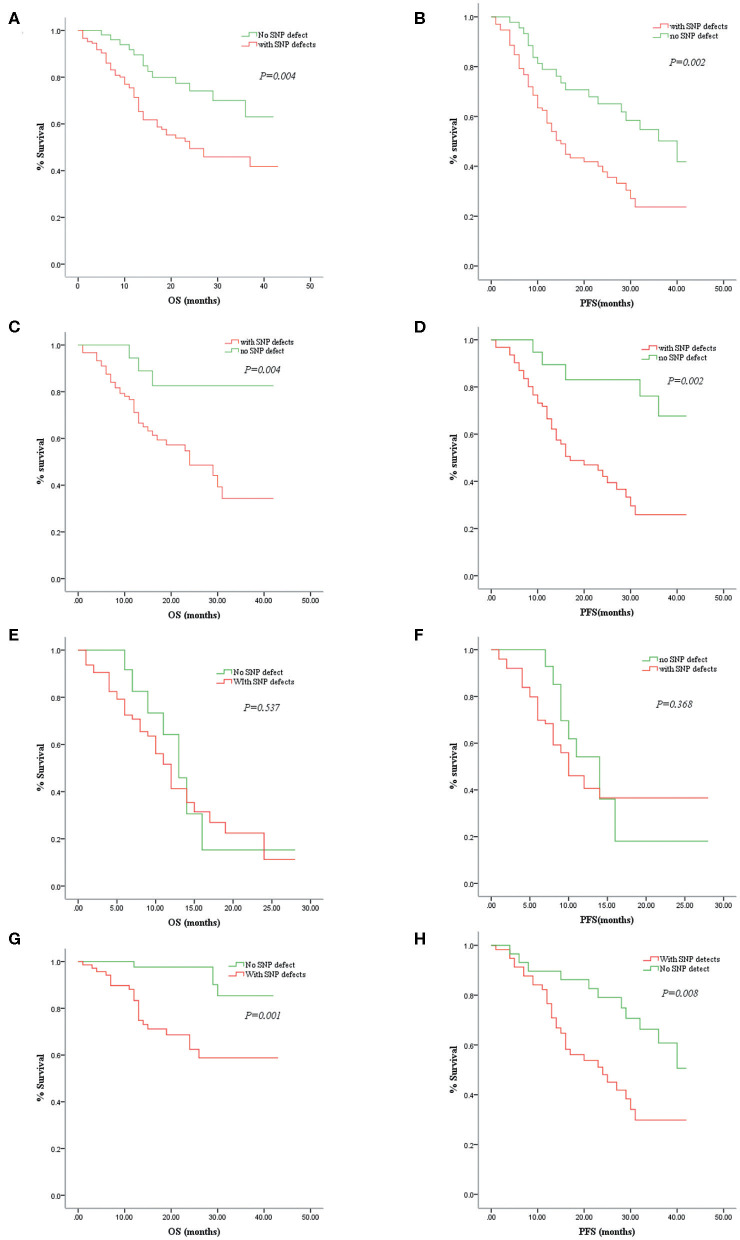
Correlations between overall survival (OS)/progression-free survival (PFS) and single-nucleotide polymorphism array (SNP-A) detections in patients with myelodysplastic syndrome (MDS). Comparison of the MDS patients with and without SNP-A aberrations in OS (A) and PFS (B). Comparison of the MDS patients with abnormal SNP-A detections and without such additional SNP-A aberrations in OS (C) and PFS (D) of the normal or good cytogenetic findings by metaphase cytogenetics (MC). Comparison of the MDS patients with and without SNP-A aberrations in OS (E) and PFS (F) of the high-risk group. Comparison of the MDS patients with and without SNP-A aberrations in OS (G) and PFS (H) of the low-risk group.